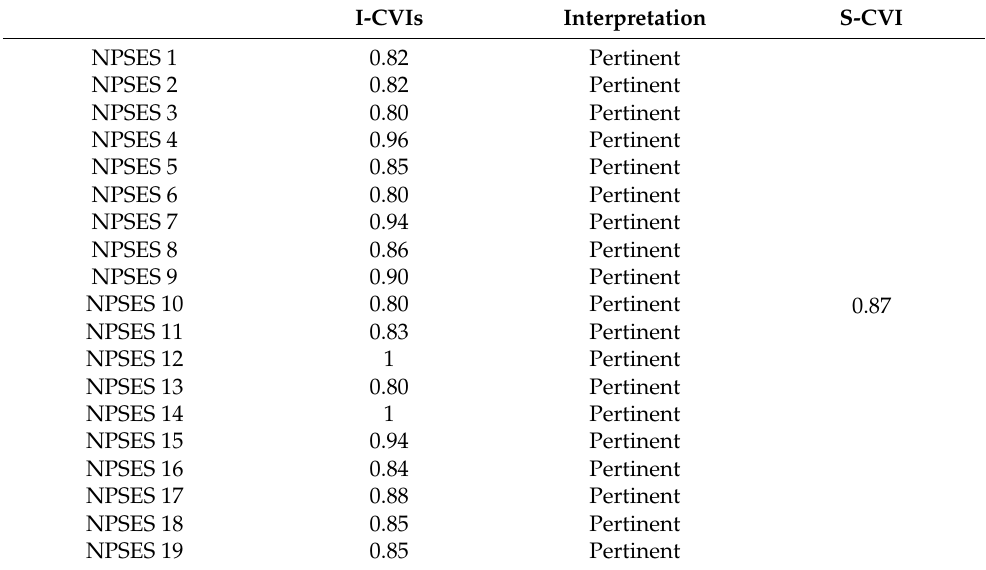
Table 2. Content validity of A-NPSES (I-CVIs and S-CVI) (N =